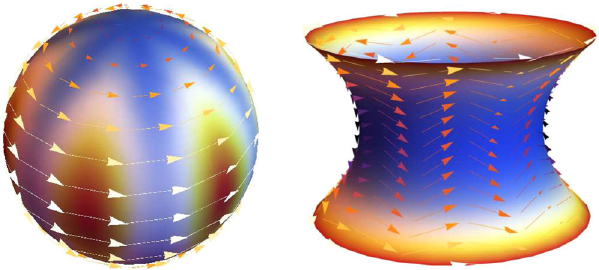
FIG. 6. A representative snapshot of the equatorial density mode on a sphere (Eq. (36)) and the localized Goldstone mode on the catenoid (Eq. (42)). For clear visualization we have chosen the perturbation a 6 , b 6 ¼ 0 . 5 and all other an, b have also taken both η ¼ μ = ¯ v 1 ¼ 2 both